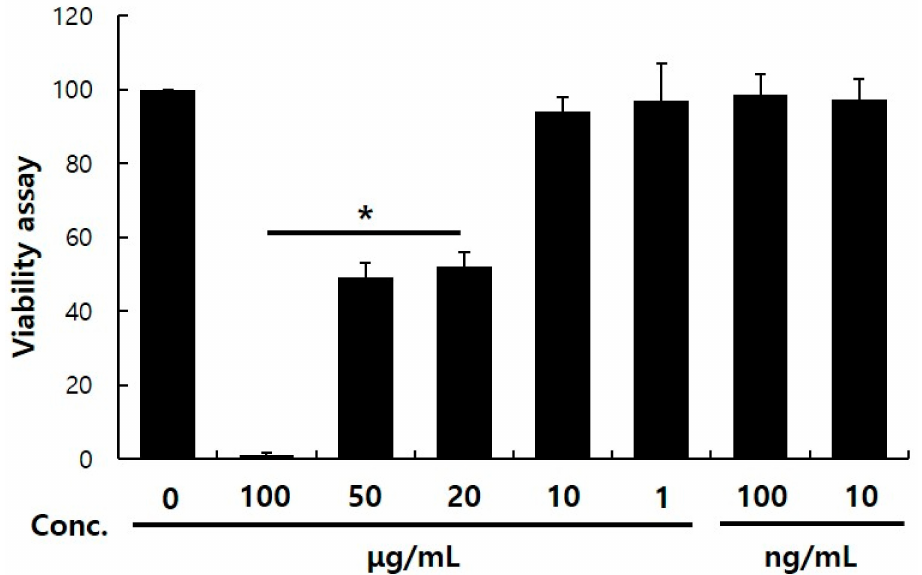
Figure 1. Cytotoxicity aspects of cycloheterophyllin on B16F10 cell line. B16F10 cells were seeded (2 × 10 4 cells) in 96-well plate and treated with the indicated concentration of cycloheterophyllin for 24 h. Cell viability was measured by CCK-8 assay. Results are presented as the mean ± S.D. of the percentage of control optical density in triplicates. * p < 0.05 compared to